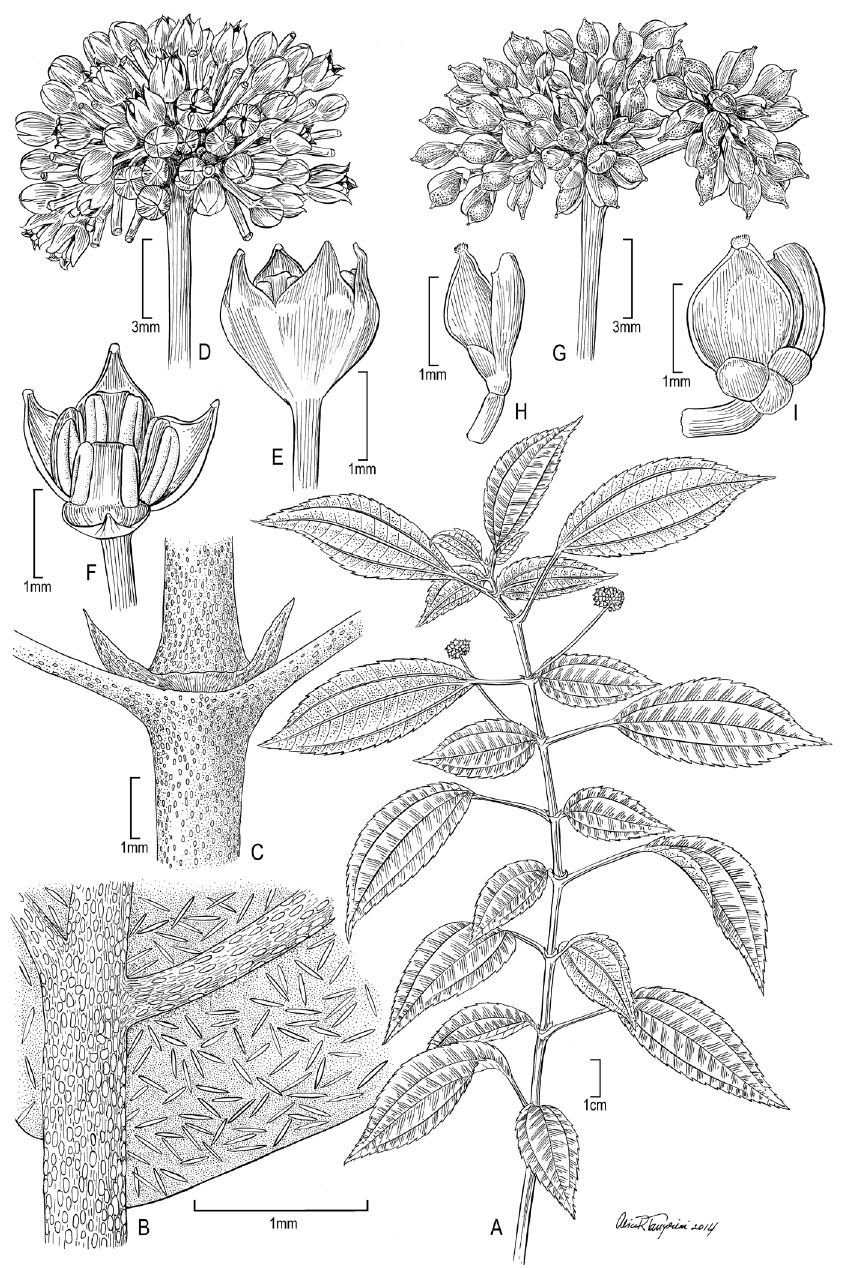
Figure 3. Pilea nicholasii . A Habit; note the unequal leaf laminae at each node B Leaf detail (major lamina upper surface) showing cystoliths C Stipules, stem, and petiole bases with cystoliths D Staminate inflorescence E Staminate flower ± in bud F Staminate flower showing stamens G Infructescence H , I Pistillate flowers with developing achenes. ( A , D – F from B. Stergios et al. 20074 (US); B , C from B. Stergios & R. Caracas 19671 (US); G – I from B. Stergios 19986